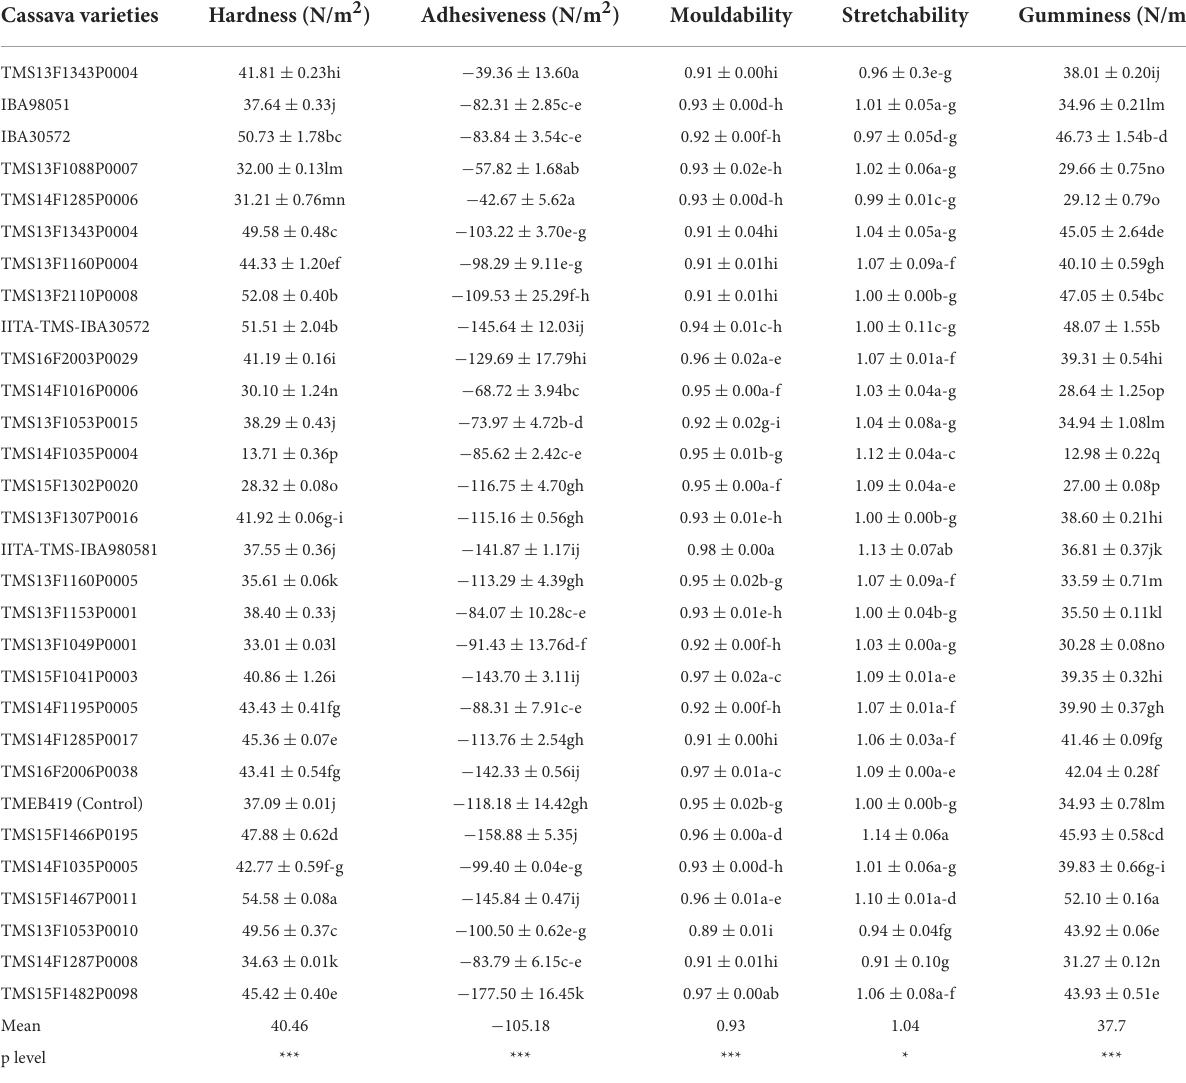
TABLE 5 Instrumental texture attributes of eba produced from the cassava genotypes and the control